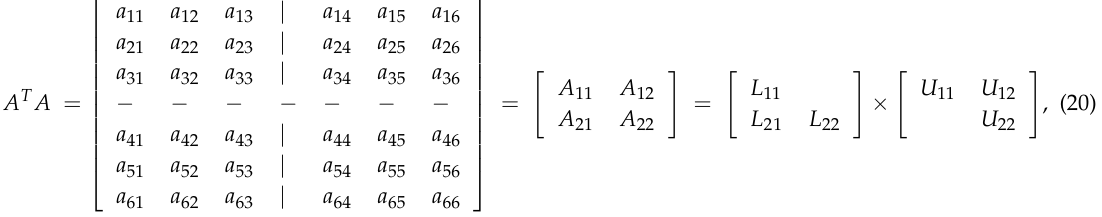
Figure 6. The architectures of T A A .